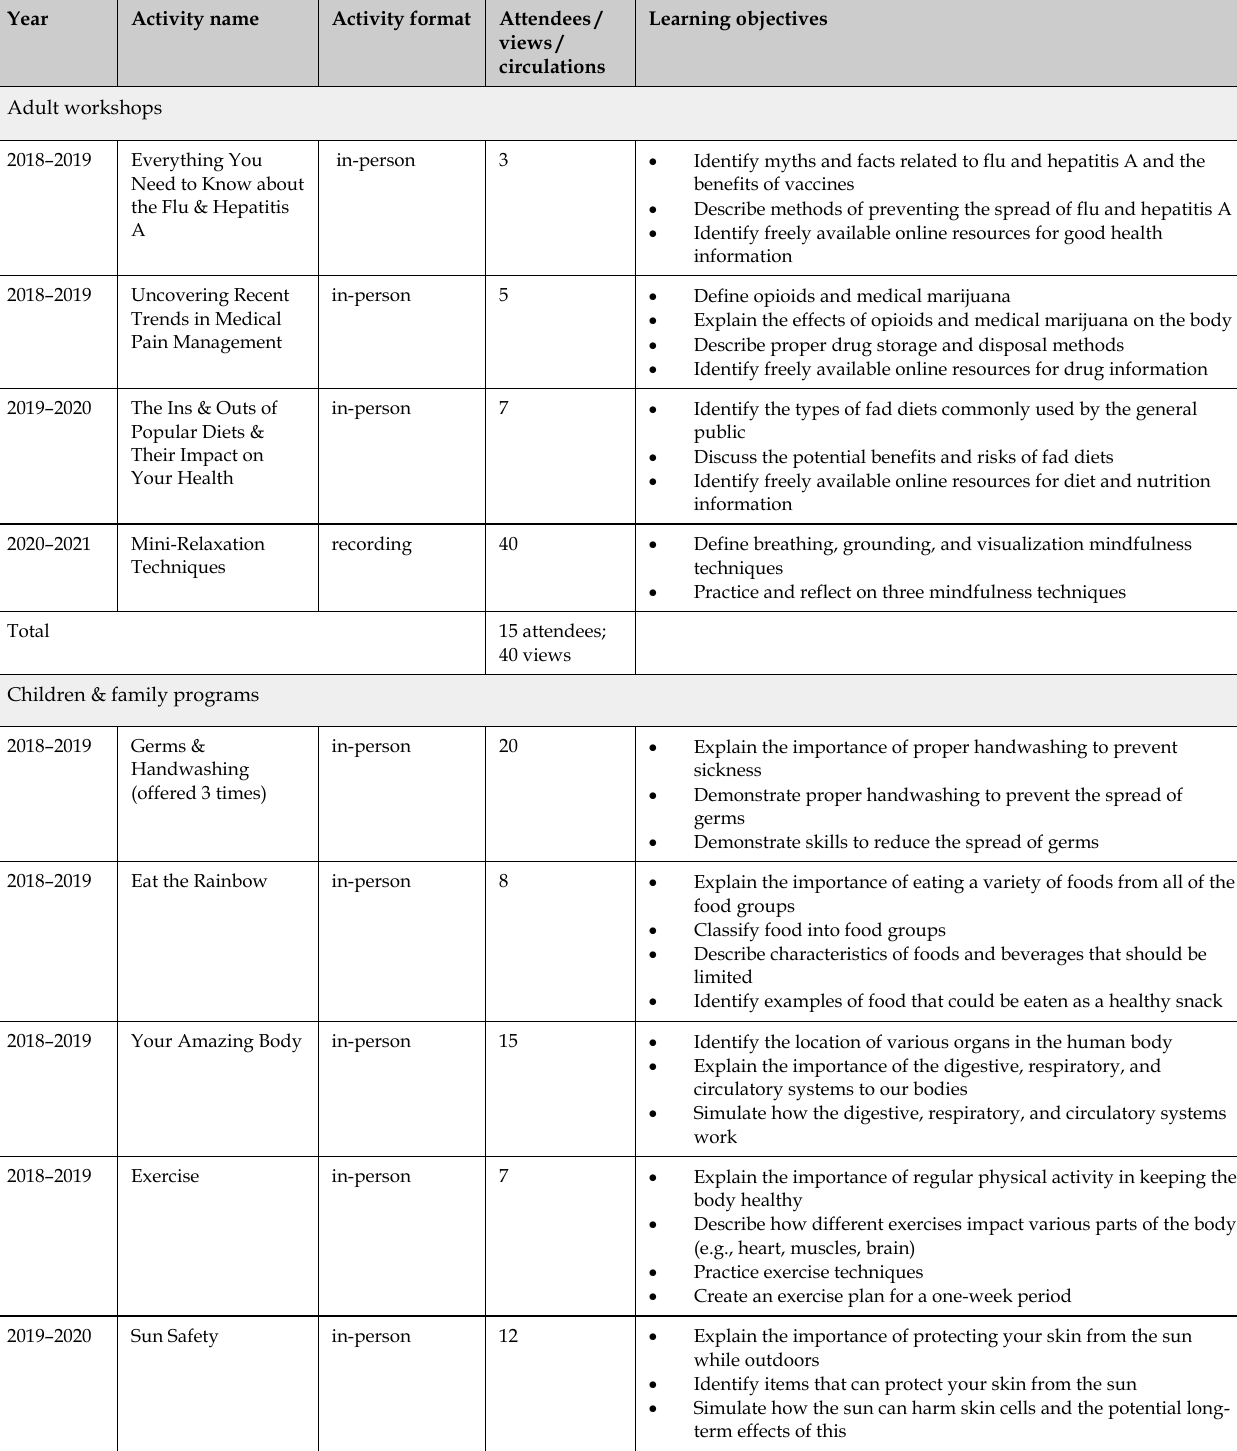
Table 1 Health education programs summary, 2018 –